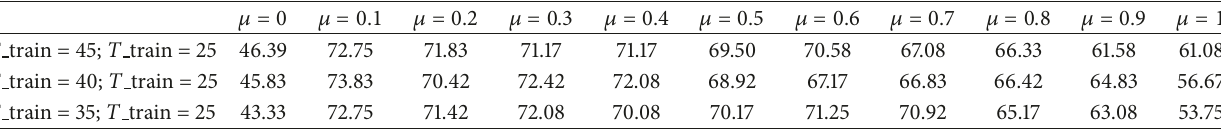
Table 3: The average recognition precision (%) in InfAR with different trade-off parameter 𝜇 .